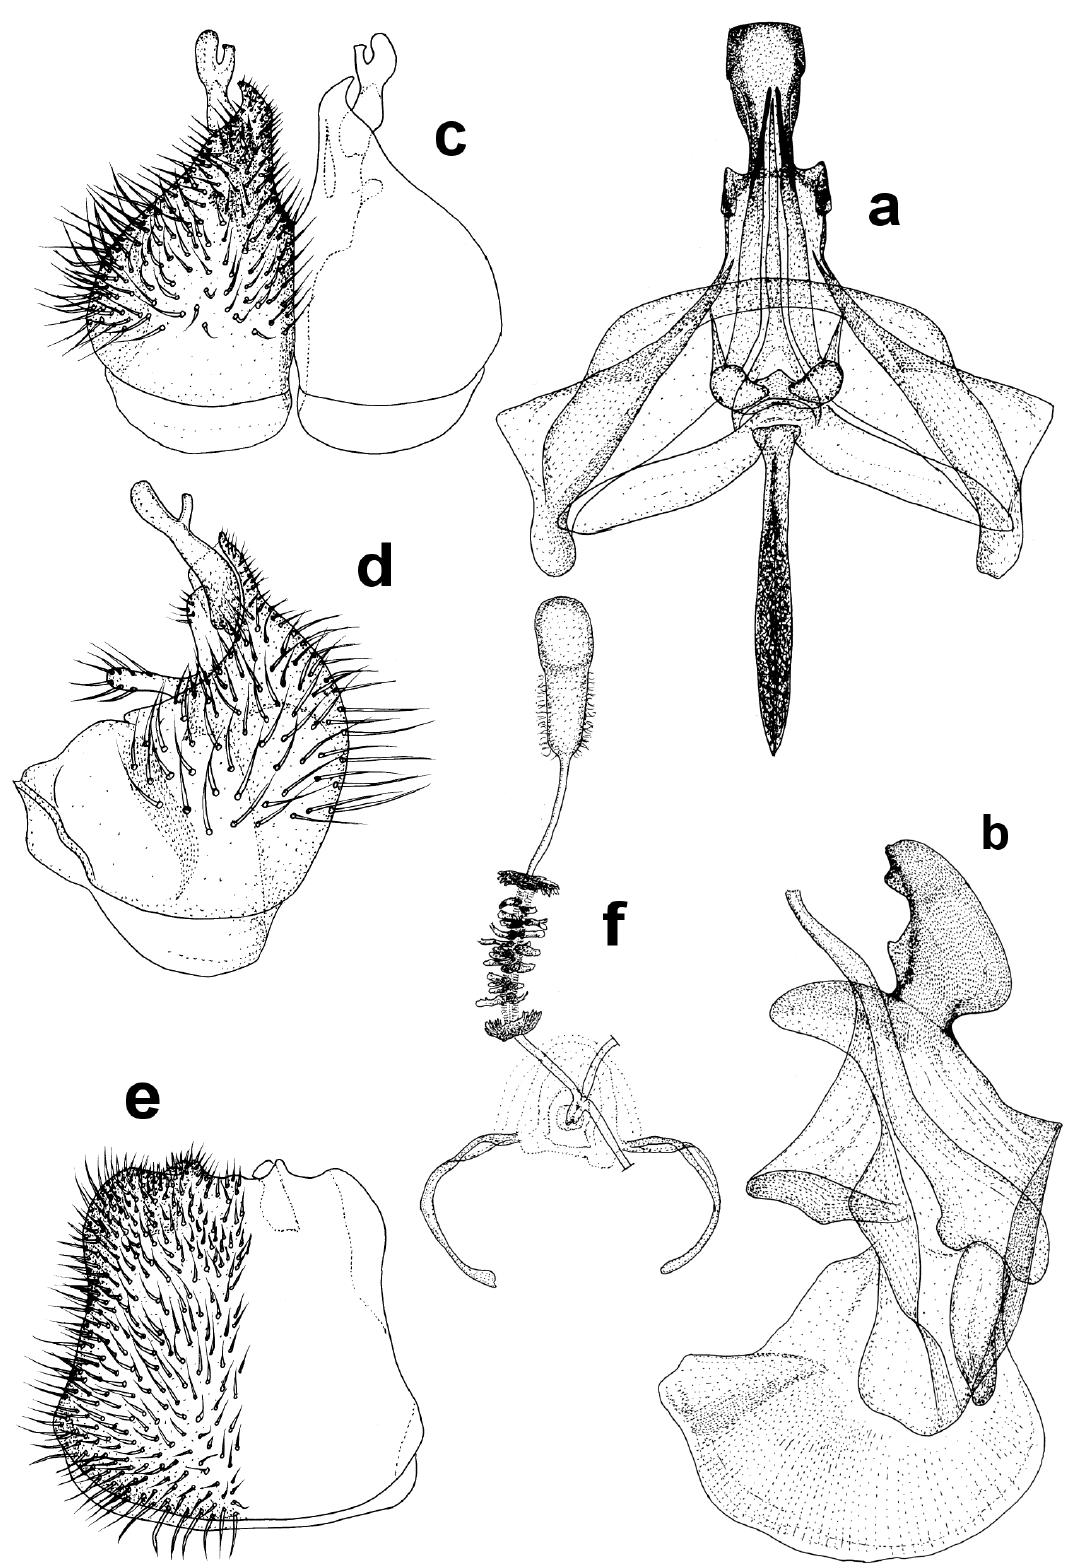
Fig. 37. Parageron longilingua sp. nov. a . Epiphallic complex ventral. b . Epiphallic complex lateral. c . Gonocoxite ventral. d . Gonocoxite lateral. e . Epandrium dorsal. f . Female genitalia